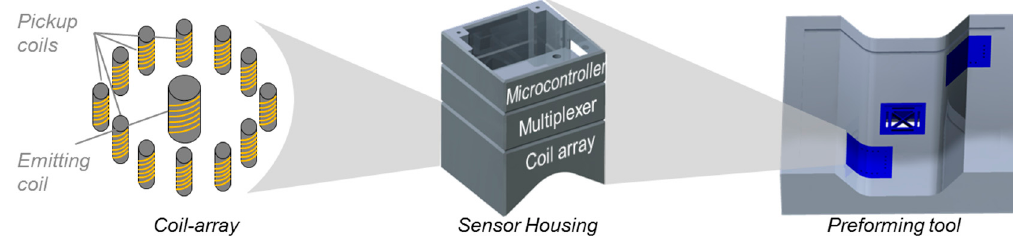
Figure 2. In-process integration of eddy current sensor arrays in preforming tools.